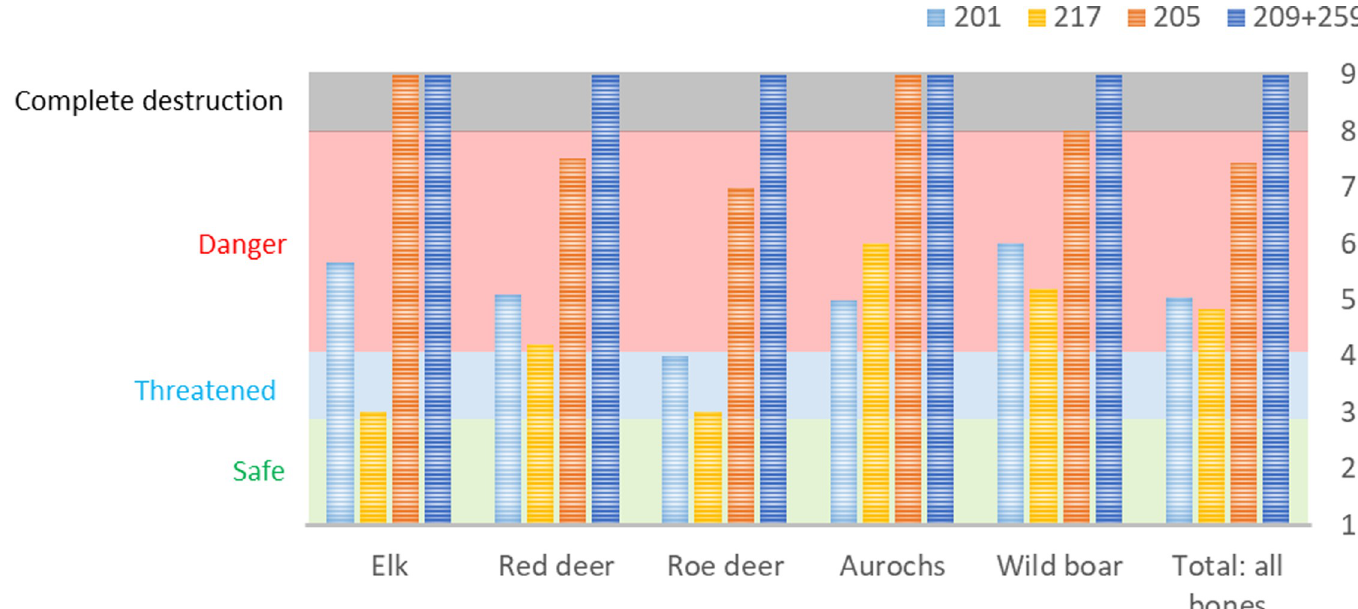
Fig 10. Mean weathering II values for the ungulates and for all bones combined, divided into the five trenches from the 2019 excavation. The severity of degradation increases with higher weathering degree numbers. Weathering degrees < 3 are considered low, 3 medium and 4–8 high, category 9 indicates lack of preserved unburnt bones. N: Trench 201 (Elk = 3; Red deer = 11; Roe deer = 2; Aurochs = 1; Wild boar = 1; Total all bones = 26); Trench 217 (Elk = 1; Red deer = 5; Roe deer = 1; Aurochs = 1; Wild boar = 5; Total all bones = 17); Trench 205 (Elk = 0; Red deer = 2; Roe deer = 2; Aurochs = 0; Wild boar = 2; Total all bones = 9); Trench 209+259 = 0.